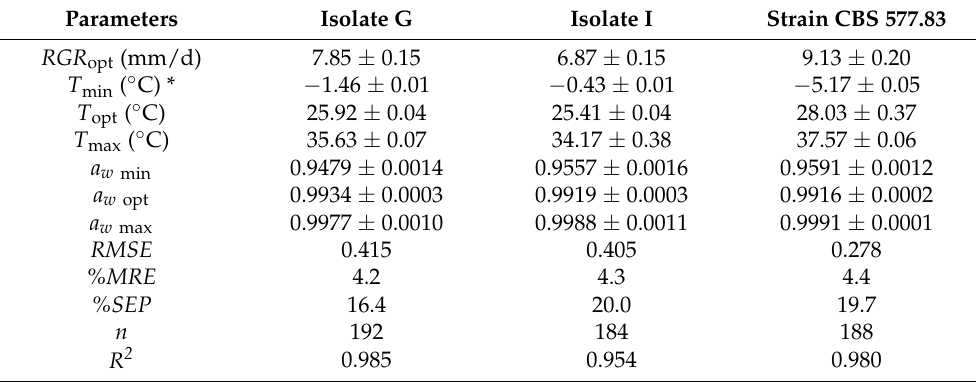
Table 2. Estimated CM parameters and statistical indices for radial growth rate ( RGR ) modelling of G. candidum against temperature and a w . Parameters Isolate G Isolate